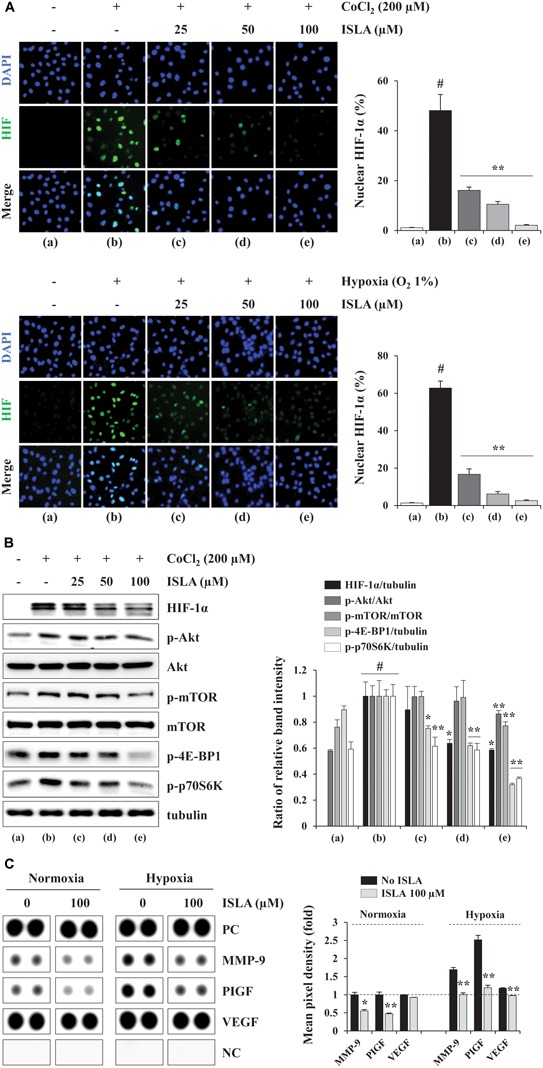
Isoliquiritin apioside suppressed HIF-1α nuclear expression and reduced the production of pro-angiogenic proteins of HT1080 cells. (A) Cells grown in glass bottom dishes were treated with the indicated concentrations of ISLA for 12 h and then exposed to hypoxic conditions including CoCl2 stimulation and 1% O2 (for 6 h. After staining with Alexa Fluor 488-HIF-1α antibody and counterstaining with DAPI, nuclear HIF-1α levels were measured. Data are representative of two independent experiments and expressed as the means ± SD of five selected fields per sample. (B) Cells were treated with or without ISLA for 12 h and then stimulated with 200 μM CoCl2 for 6 h. The levels of HIF-1α as well as molecules downstream of HIF-1α in total cell lysates were detected by western blotting. The relative band intensities were calculated using ImageJ software after normalization to tubulin expression and expressed as the mean ± SD from two independent experiments. (C) The levels of angiogenesis-related proteins were measured in HT1080 CMs obtained from ISLA-treated or untreated cells incubated under normoxic (20% O2) and hypoxic (1% O2) conditions. The pixel intensities from duplicate dots were measured, and the relative values compared with untreated control cells under normoxia were calculated. The data are representative of two independent experiments and expressed as the means ± SD of duplicate dots. #p < 0.01 vs. untreated control, ∗p < 0.05, ∗∗p < 0.01 vs. ISLA-untreated control.)